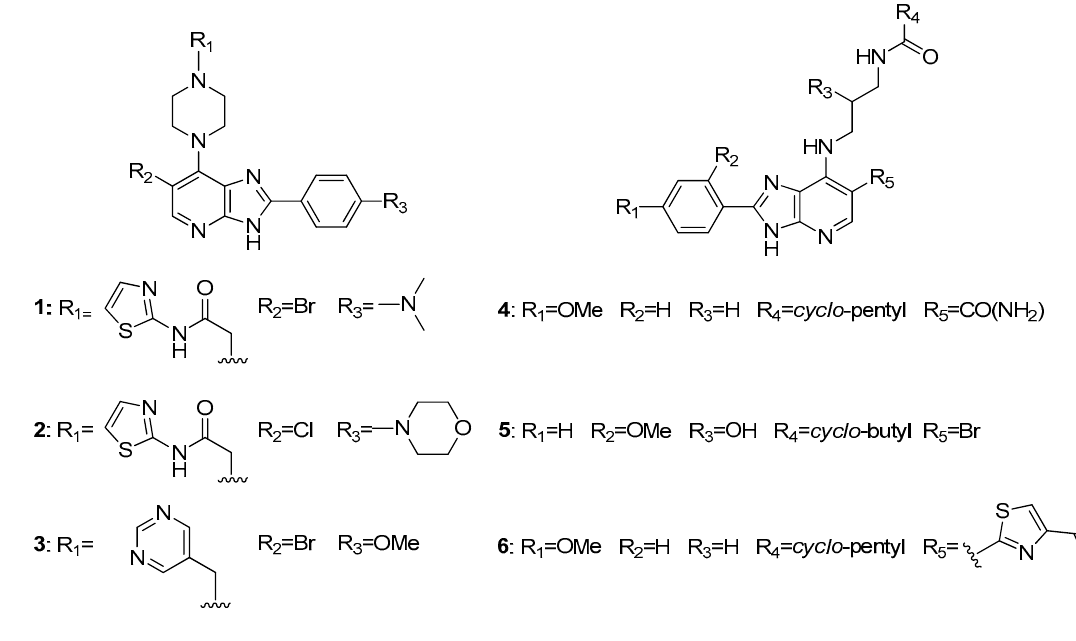
Figure 3. Inhibitors of serine/threonine kinases.